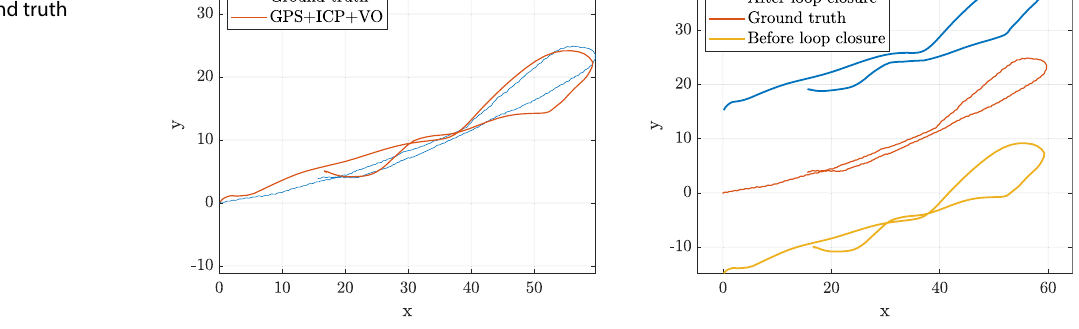
Fig. 9 Comparison of trajecto- ries with the ground